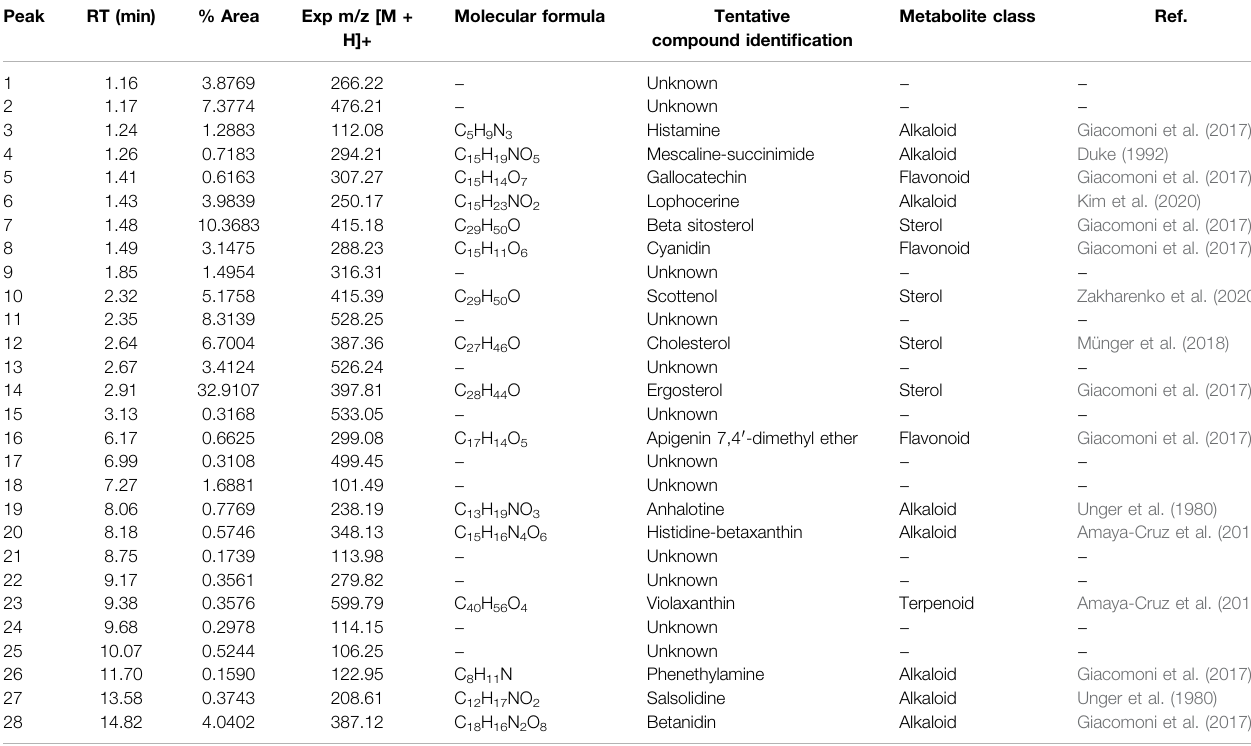
TABLE 6 | Secondary metabolites present in the nonpolar fraction of the extract of Lophocereus schottii. Peak RT (min) % Area Exp m/z [M + Molecular formula Tentative Metabolite class H]+ compound identi fi cation